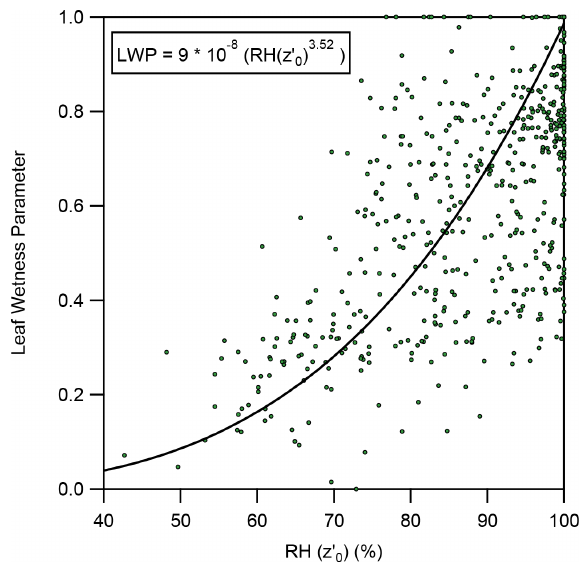
Figure 7. Scatter plot of hourly leaf wetness parameter and rela- tive humidity z (cid:48) measurements taken during campaign, with a fitted 0 power